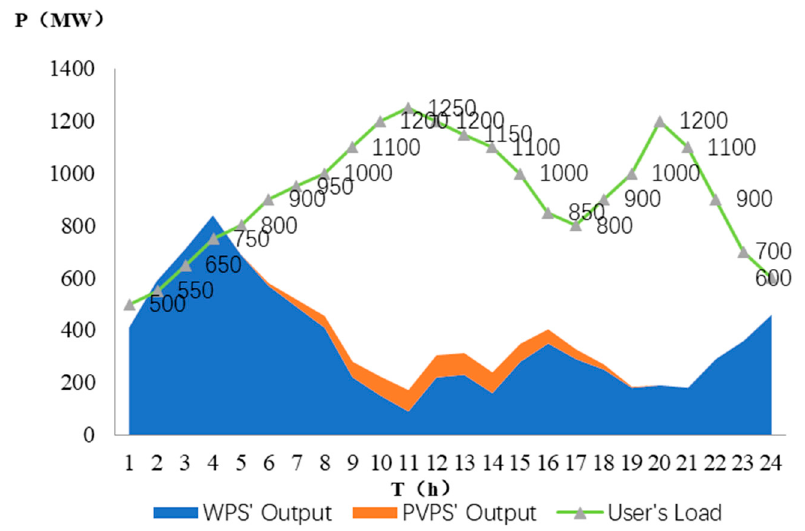
Figure 5. Output of the photovoltaic power sellers (PVPS) and wind power sellers (WPS), and the load demands of end-users in a typical winter day.